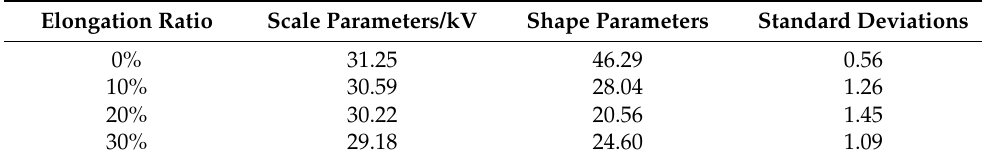
Table 2. Weibull parameters of AC breakdown voltage.